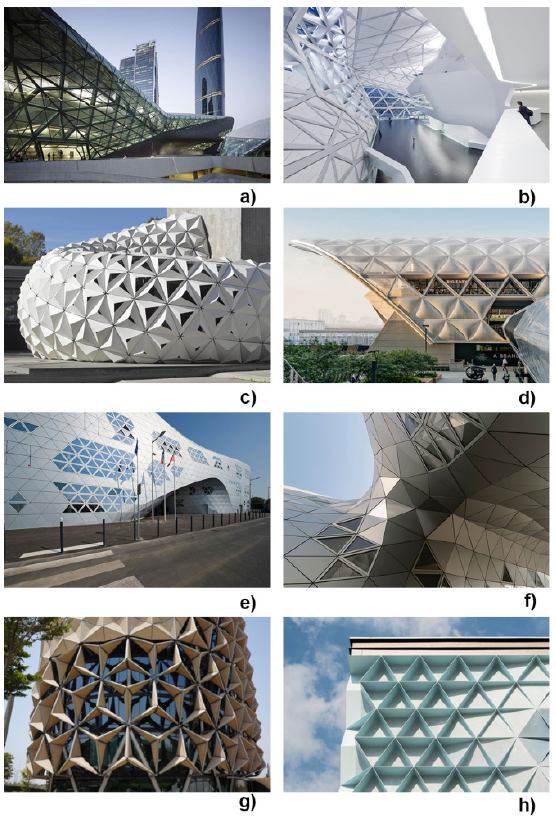
Figure 1. Application of polyhedral surfaces in architecture and engineering: a) and b) Guangzhou opera house, c) ArboSkin Pavilion, Stuttgart University, d) Canary Wharf Crossrail Station, London, e) and f) Georges-Freche School of hotel Management, Montpellier, g) Al Bahr Tower, Abu Dhabi, h) Rong Num Kaeng,